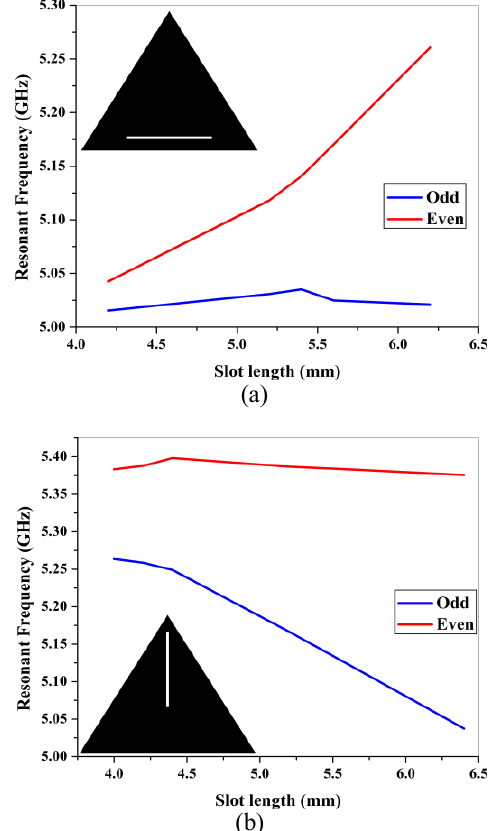
Figure 5: Separation of dual resonant frequencies with (a) horizontal slot and (b) vertical